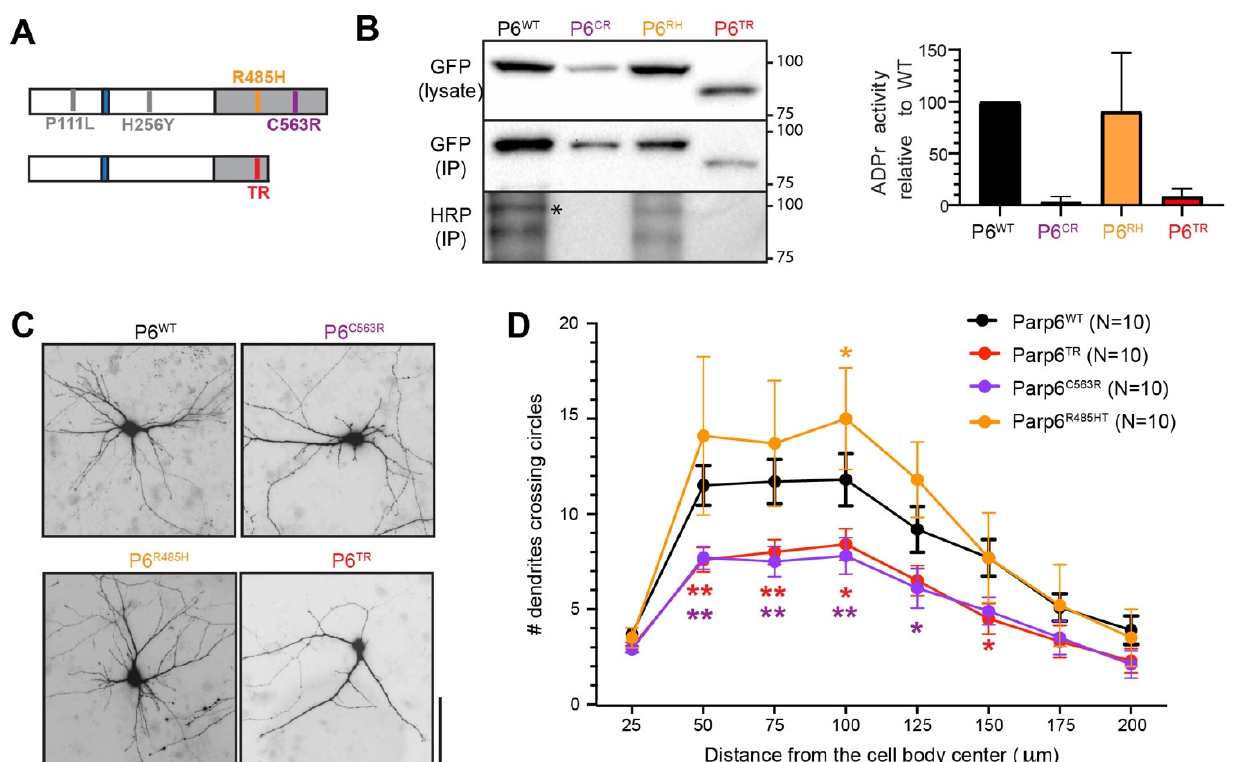
Figure 6. Parp6 TR and Parp6 C563R expressing hippocampal neurons showed decreased MARylation activity of Parp6, as well as reduced dendritic branching. ( A ) Schematic representation of Parp6 WT showing the position of the extra neuronal sequence (blue), the catalytic domain (gray), and the location of the identified clinical point mutations PARP6 P111L , PARP6 H256Y , PARP6 R485H/C , and PARP6 C563R found in patients. ( B ) Western blot of the auto mono-MARylation of Parp6 WT , Parp6 C563R , Parp6 R483H , and Parp6 TR . (*) indicates GFP-Parp6 protein (left), and quantification of ADPr activity of the different Parp6 constructs (right). ( C ) Parp6 R485H increased, whereas Parp6 C563R and Parp6 TR significantly decreased dendritic complexity in primary hippocampal neurons. E18 primary rat hippocampal neurons were co-transfected with mApple (filler) and GFP-Parp6WT (control), GFP-Parp6 C563R , GFP-Parp6 R485H , or GFP-Parp6 TR on DIV7 and fixed on DIV12. Shown are representative binary images generated from fluorescent images. Scale bar, 20 μ m. ( D ) Quantification of results in ( C ) using Sholl analysis. Error bars represent SEM. * p < 0.05, ** p < 0.001 (one-way ANOVA followed by Tukey’s HSD test) compared to Parp6 WT .